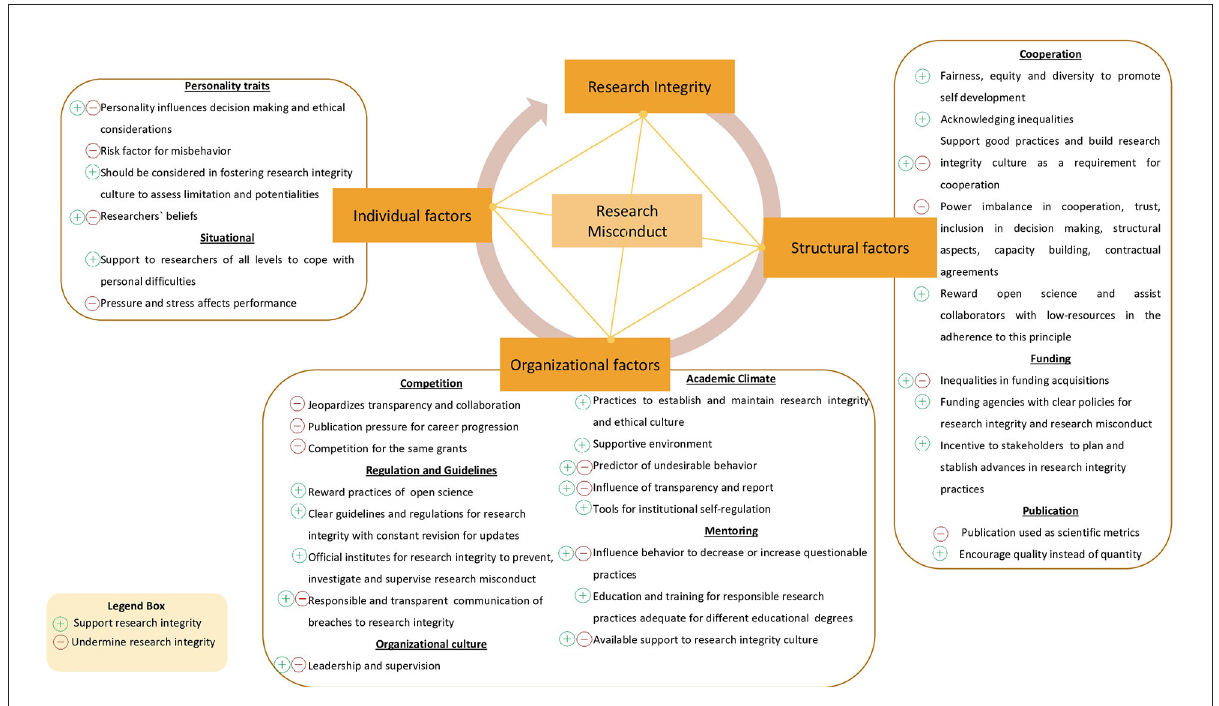
FIGURE1 Research integrity factorize the network that influence